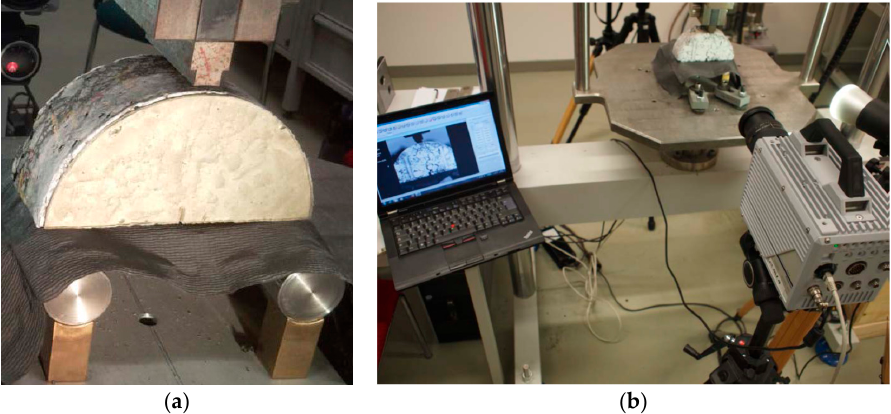
Figure 2. Experimental setup of the static three-point semi-circular bend test (3PSCBT). ( a ) Test setup of the 3PSCBT, ( b ) setup for crack detection.